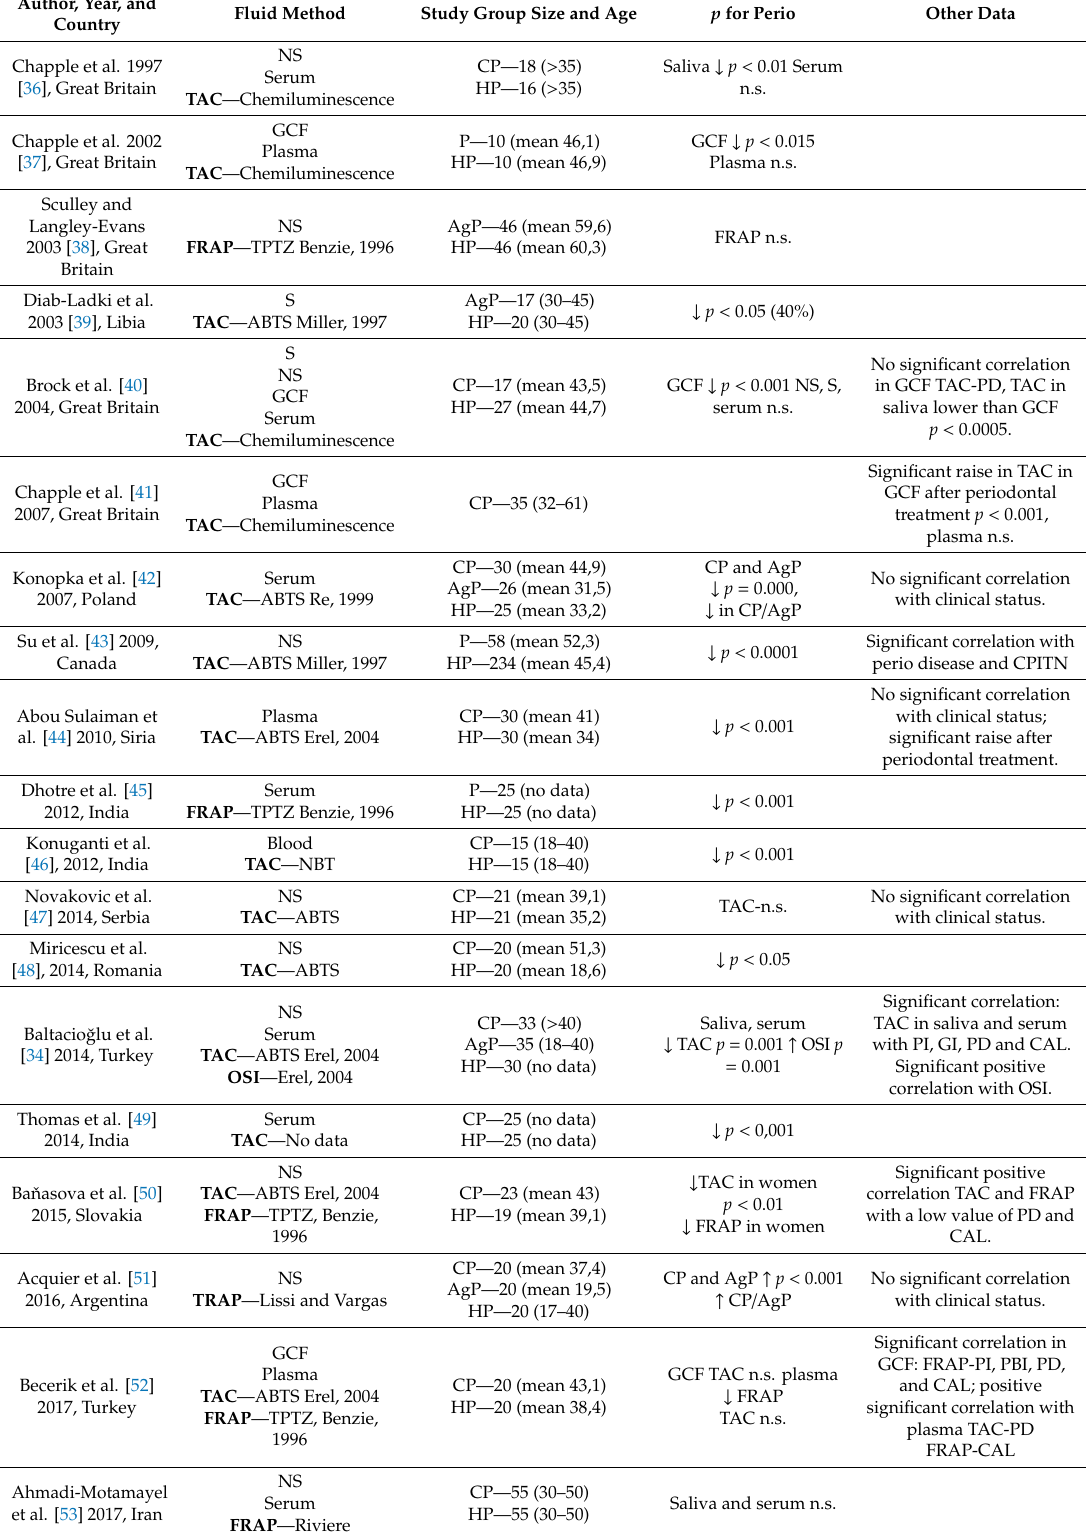
Table 2. Comparison of studies on total antioxidant capacity in